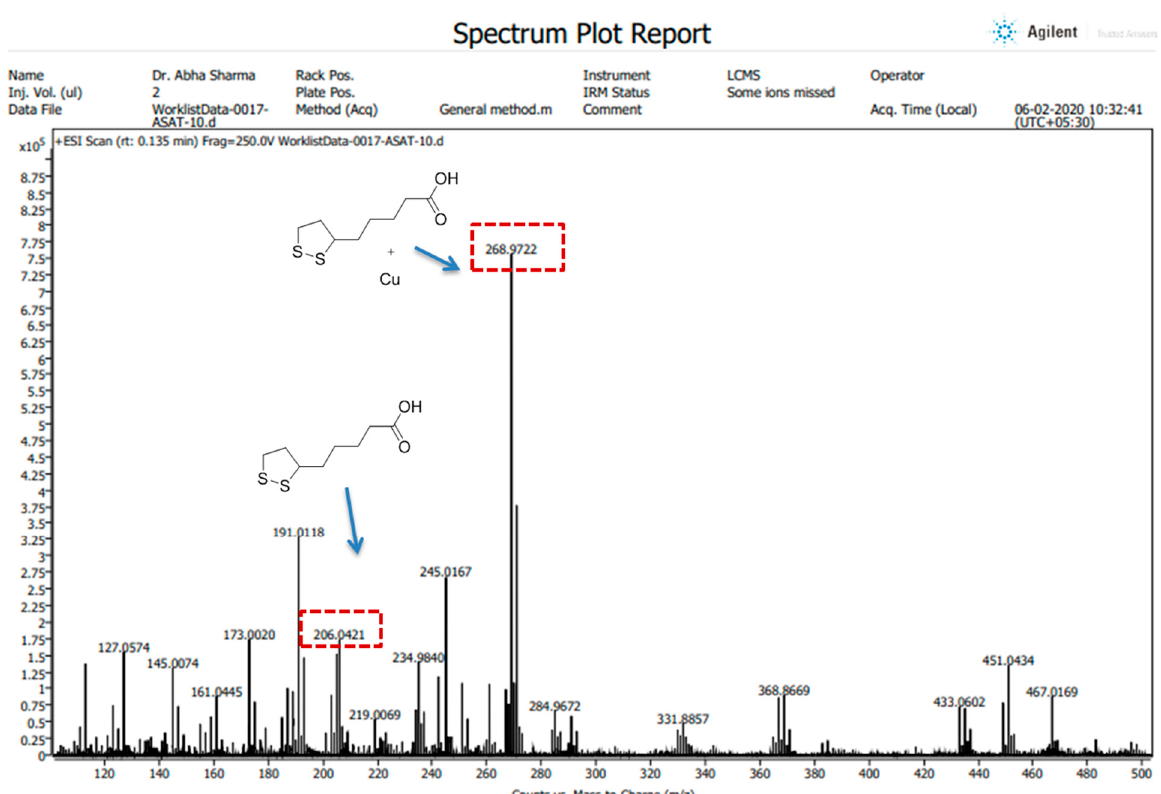
Figure 6. HRMS spectra of ALA and ALA with Cu. The complex between ALA with Cu was further confirmed by HRMS and shows the mass adduct formation of ALA alone at 206.04 and with Cu at 268.97.